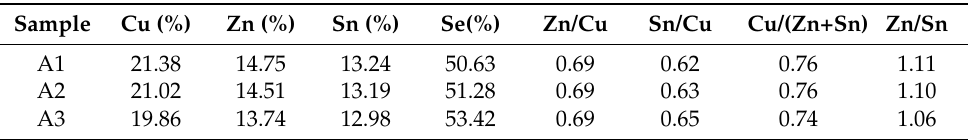
Table 2. The elemental contents of the CZTSe films that were prepared by the selenization of the precursor with samples A1, A2, and A3 in a SnSe x +Se vapor atmosphere.